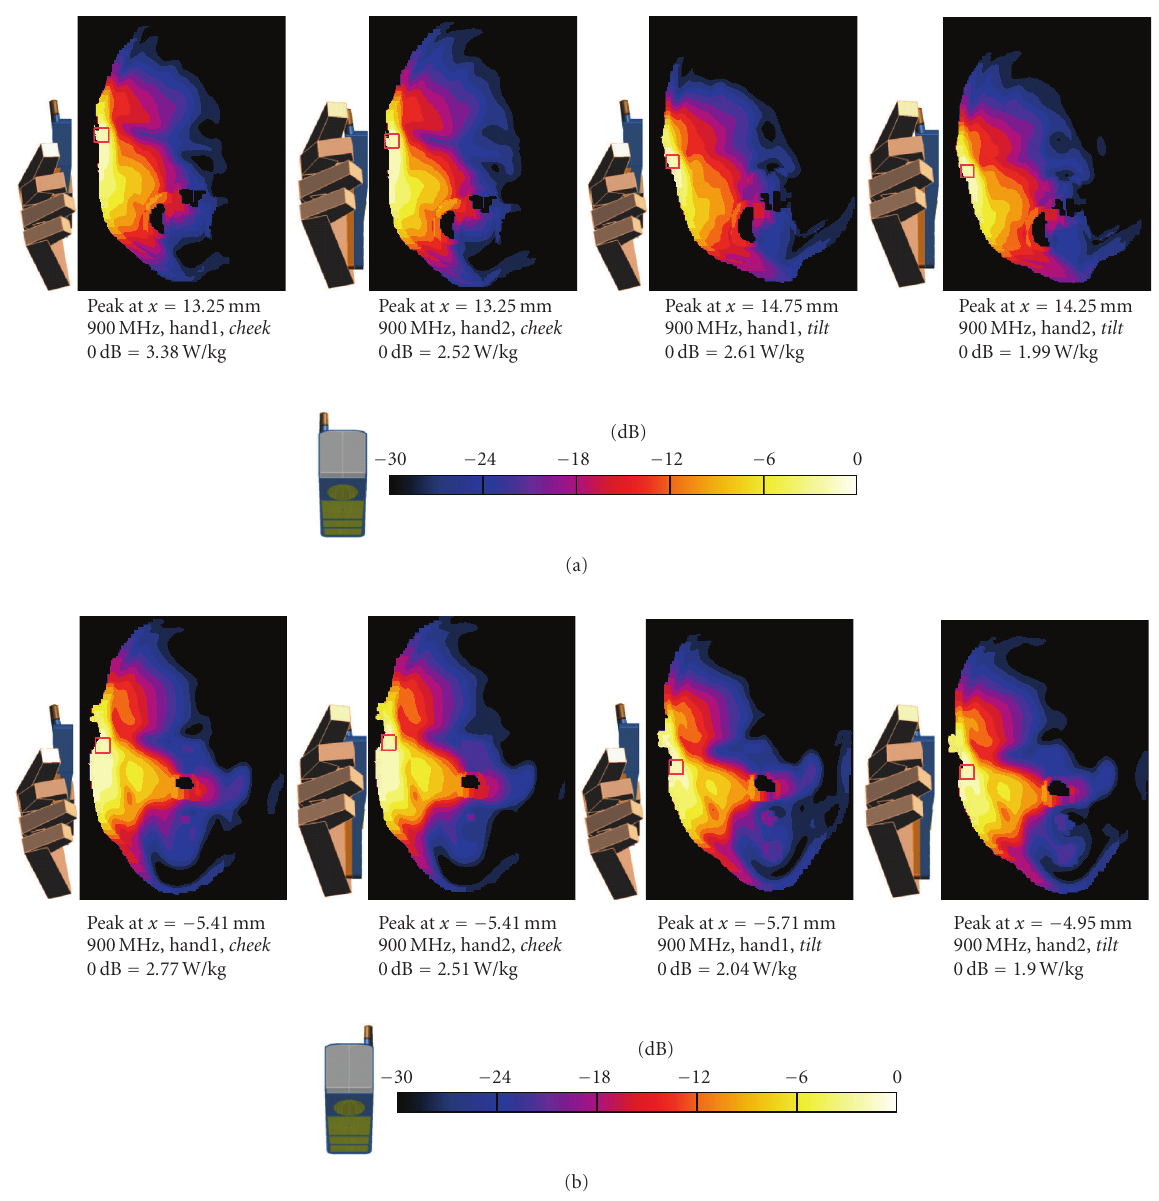
Figure 7: Sliced distribution of the averaged-peak SAR 1g in the yz -plane, normalized to 0.6 W input power, of the HR-EFH at di ff erent positions due to the exposure at 900MHz of (a) handset model-A1 and (b) handset